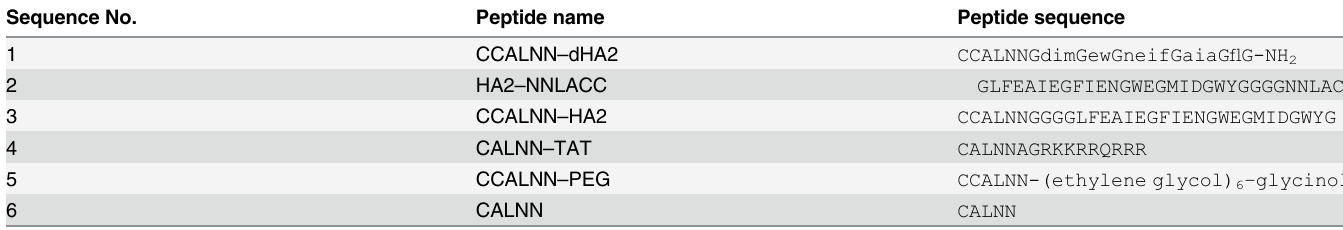
Table 1. Nomenclature of the peptides utilised, with the short names and corresponding amino acid sequences. Sequence